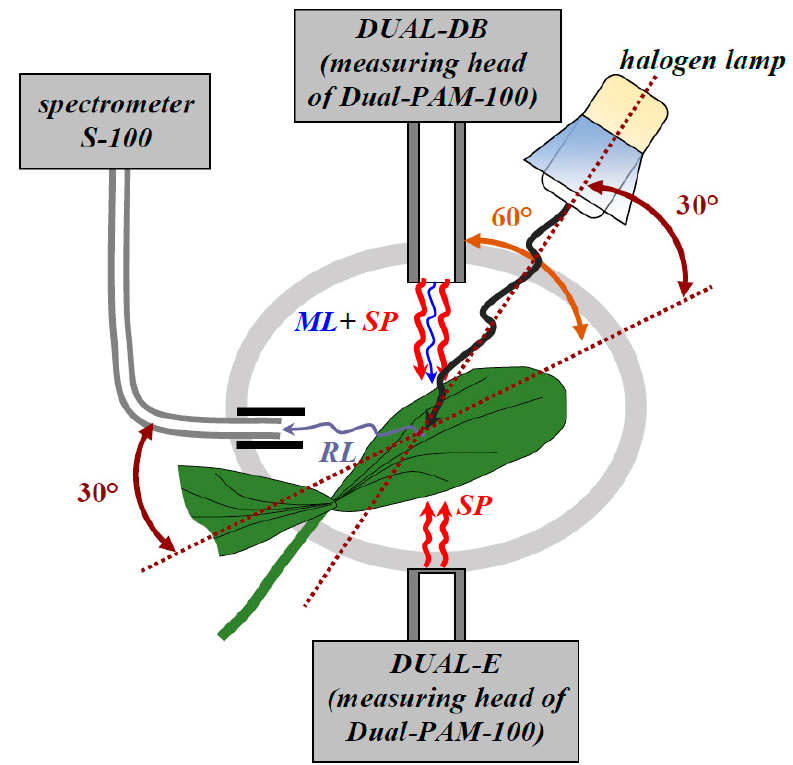
Figure 1. Schema of measurements of maximal quantum yield of photosystem II (Fv/Fm) and intensity of reflected light in leaves of pea, wheat, and pumpkin seedlings. Leaves of investigated plants were kept at a fixed angle. Measuring light (ML) refers to standard pulses of a weak blue light (460 nm, 24 µ mol m − 2 s − 1 , 2.5 µ s pulse length). Saturation pulse (SP; red light, 630 nm, 10,000 µ mol m − 2 s − 1 , 300 ms) was used for estimation of Fv/Fm before illumination by white actinic light (AL). MLs and SPs were generated by Dual-PAM-100, including blocks DUAL-DB and DUAL-E. A halogen lamp Osram Decostar was used as a source of white AL (about 630 µ mol m − 2 s − 1 ); duration of illumination was 9 min. Reflected light (RL) was measured by an S-100 spectrometer. Angle of light incidence on leaf surface was about 30 ◦ , angle between leaf surface and input for RL was about 30 ◦ , and angle between leaf surface and direction of SP and ML was about 60 ◦ .